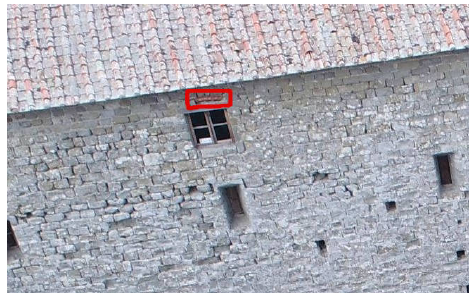
Figure 8. Misclassified area (shown within a red